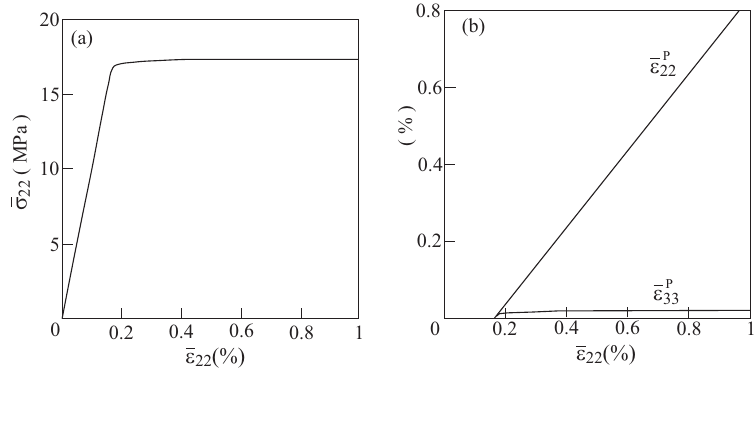
Figure 12. The elastoplastic response of aluminum with voids in the array with θ = 90 ◦ that generates a positive effective elastic Poisson’s ratio. ( a ) Average transverse stress and ( b ) transverse plastic